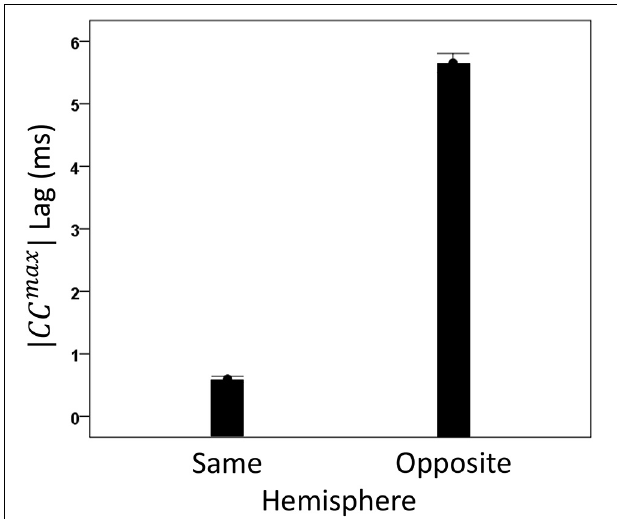
(cid:2) (cid:2) (cid:2) CC max (cid:2) for same- and